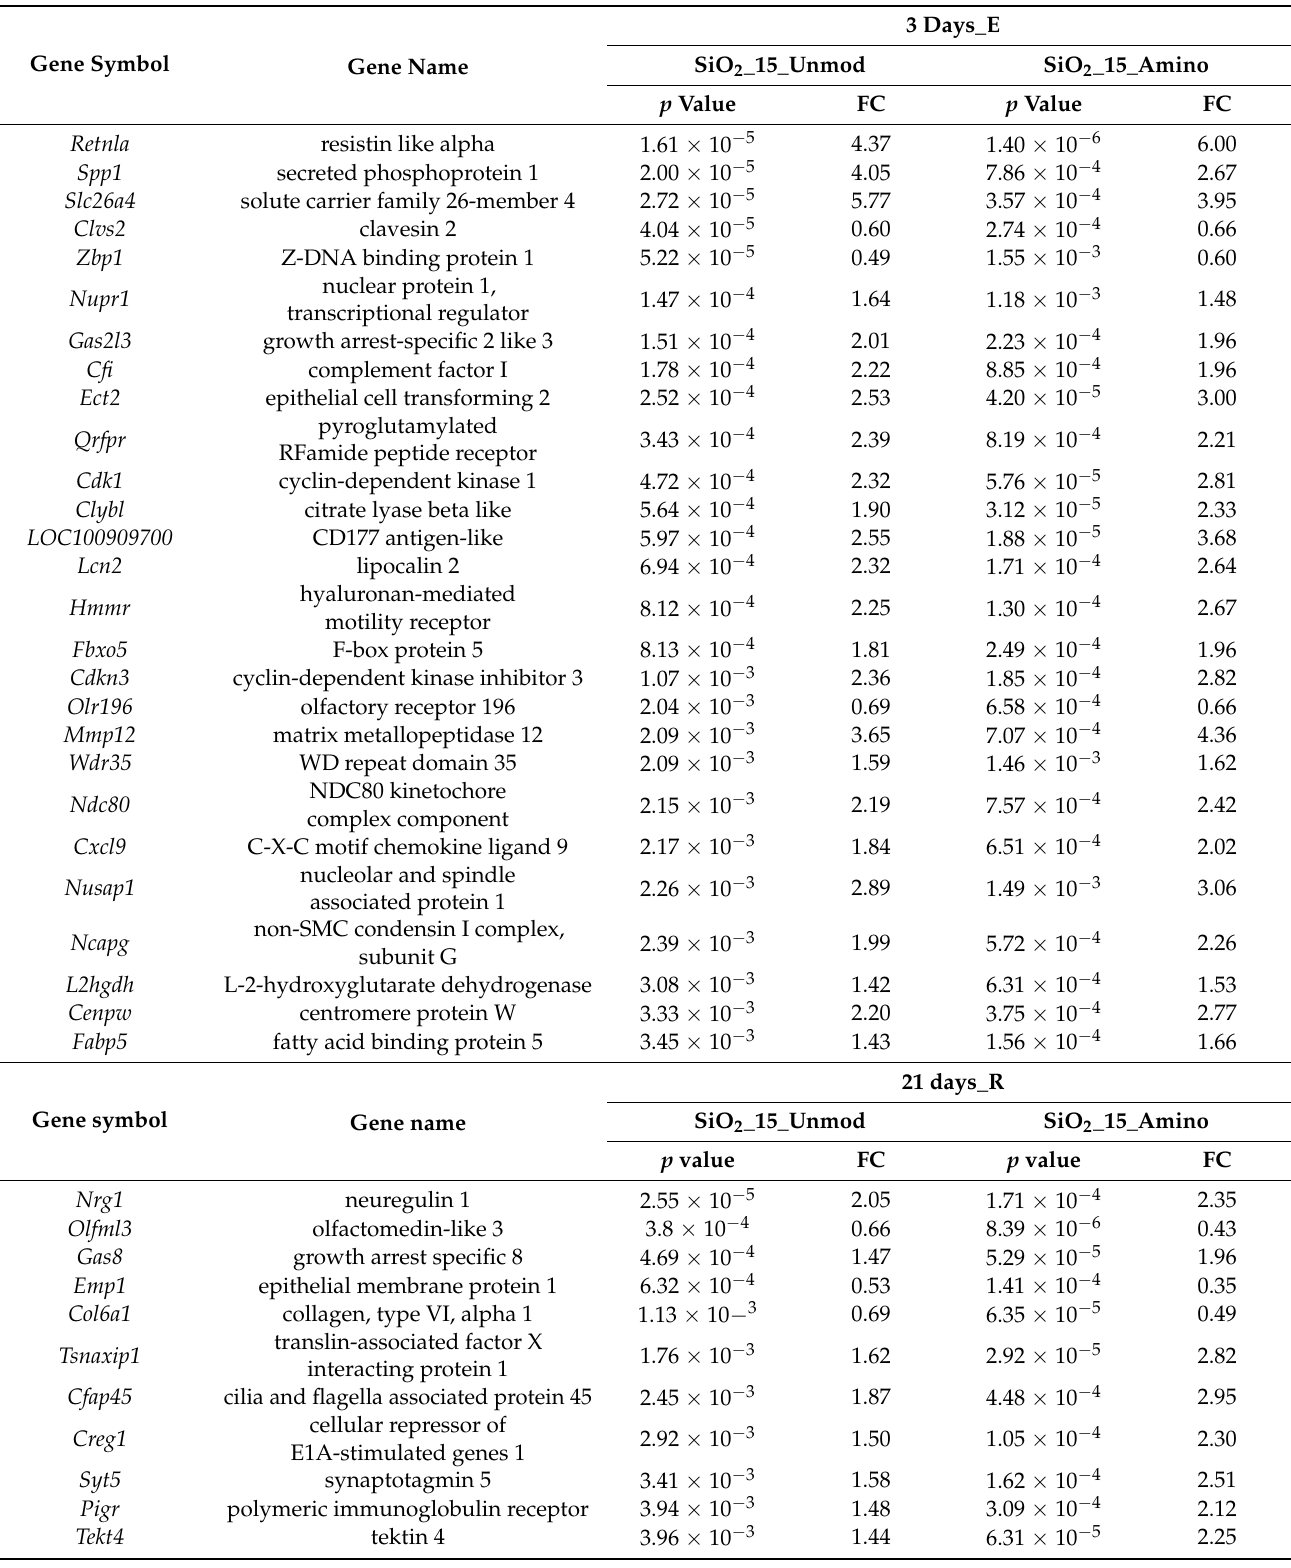
Table 6. Lung gene expression changes shared by rats exposed by instillation to SiO 2 _15_Unmod and SiO 2 _15_Amino.